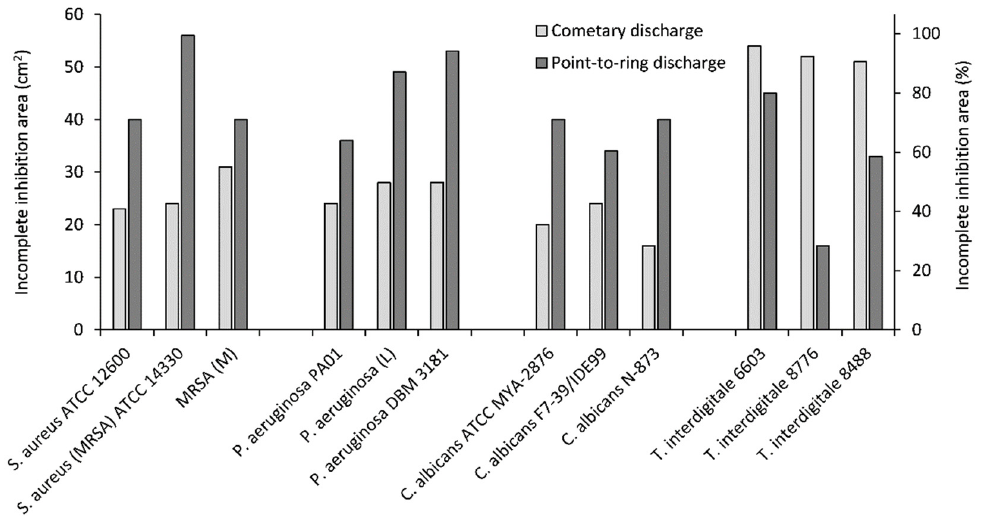
Figure 5. Areas of incomplete inhibition after exposure of individual microorganisms to the cometary/point-to-ring discharge for 60 min.